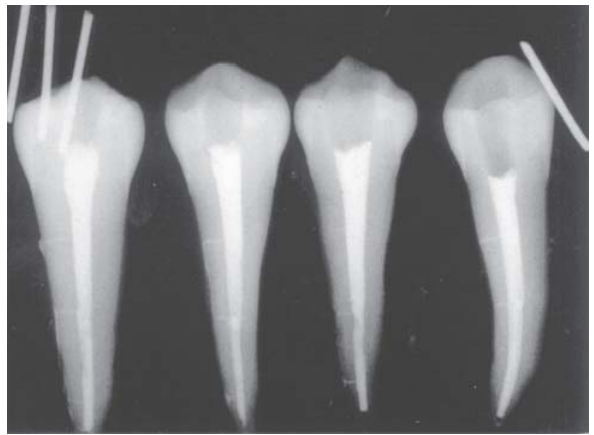
FIGURE 2- Radiograph image of teeth after the filling of the buccal lateral canals